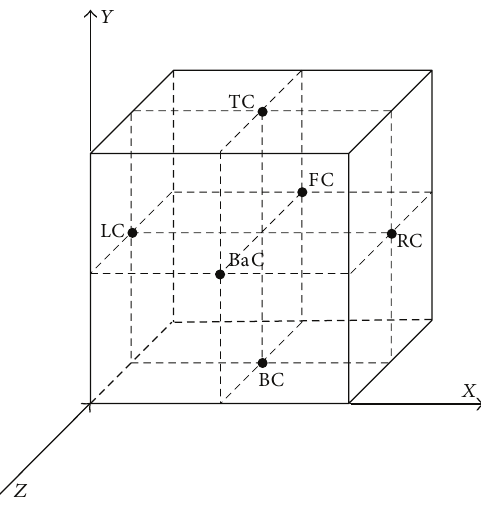
Figure 1: Modified central differencing in three-space dimensions. Figure 2: Reconstructions in the 𝑥 -, 𝑦 -, and 𝑧